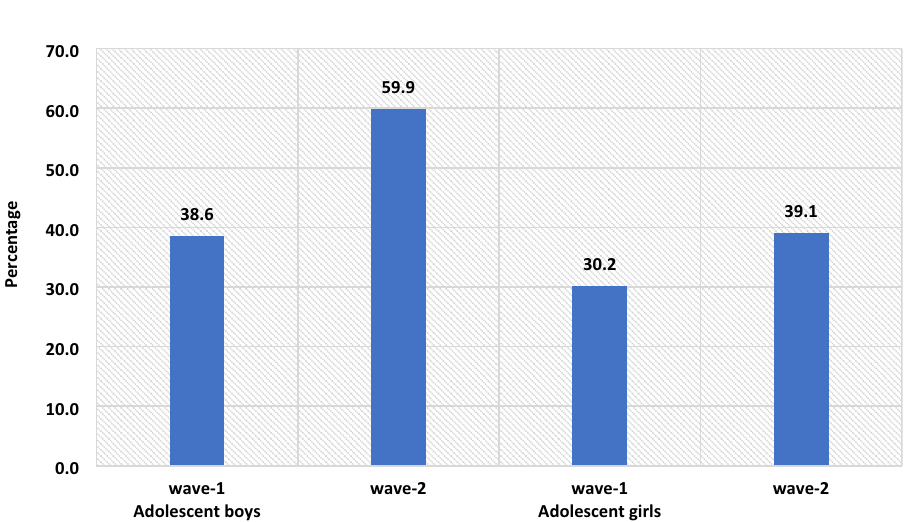
Figure 1. The percenate of HIV awareness among adolescent boys and girls, wave-1 (2015–2016) and wave-2